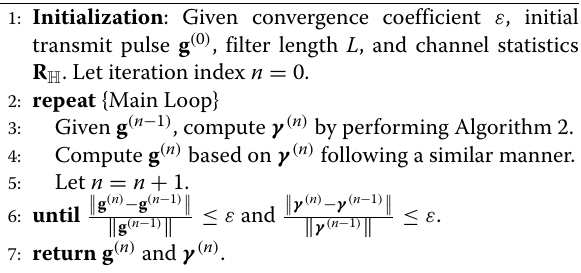
Algorithm 3 Joint transmit and receive filters optimiza- tion with channel